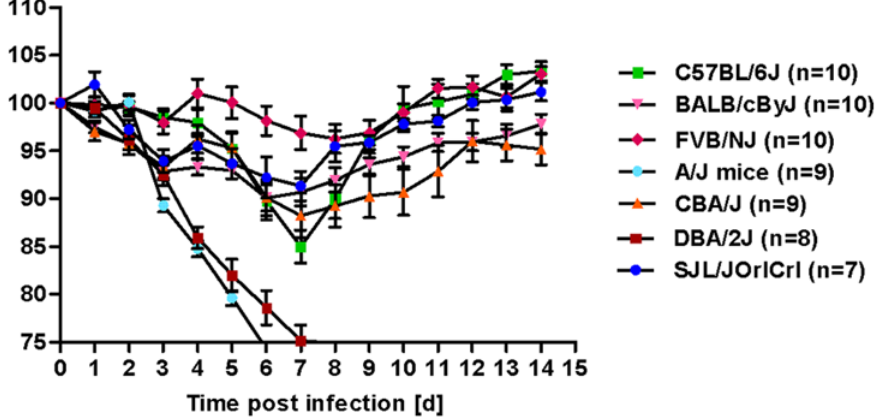
Figure 1. Different inbred laboratory mouse strains exhibit variable kinetics of weight loss and survival after infection with Influenza A virus. C57BL/6J, DBA/2J, FVB/NJ, CBA/J, BALB/cByJ, A/J and SJL/JOrlCrl mice were infected intra-nasally with 2 6 10 3 FFU of PR8 virus. Weight loss and survival of infected mice was followed over a period of 14 days. Mortality also includes mice that were sacrificed because they had lost more than 25% of body weight. Mean percent of body weight change ( 6 SEM) for each group of inbred strains is shown. For DBA/2J and C57BL/ 6J mice, data are from two independent experiments. Statistical analysis of pair wise comparisons for all strains and days are presented in table 1.